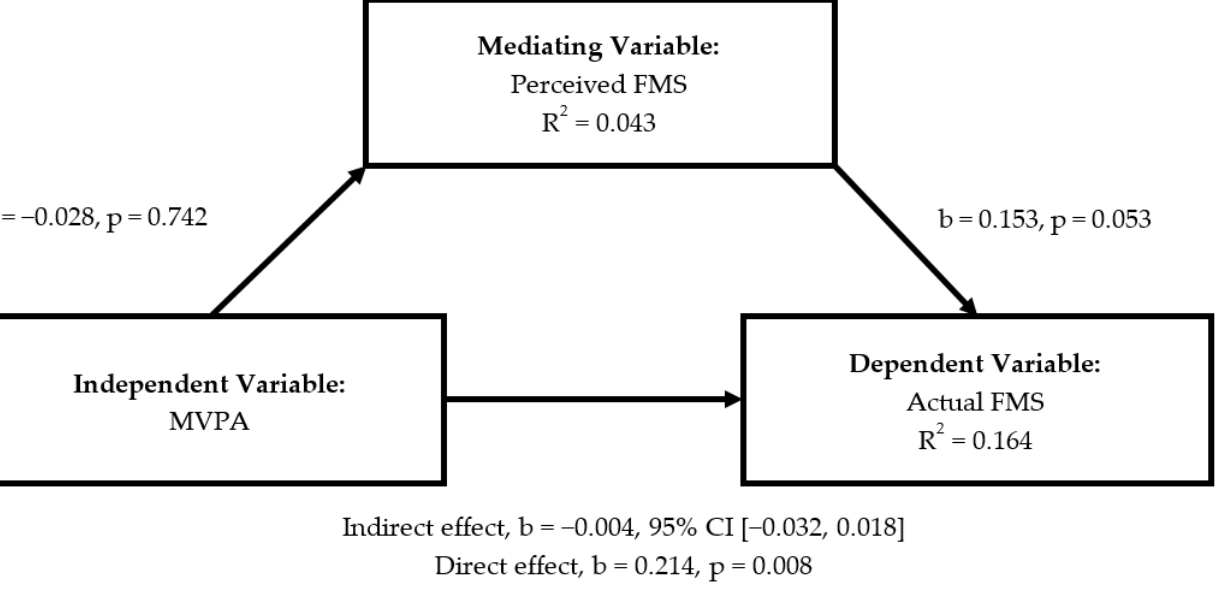
Figure 2. Mediating roles of perceived FMS in the association between MVPA and actual FMS.